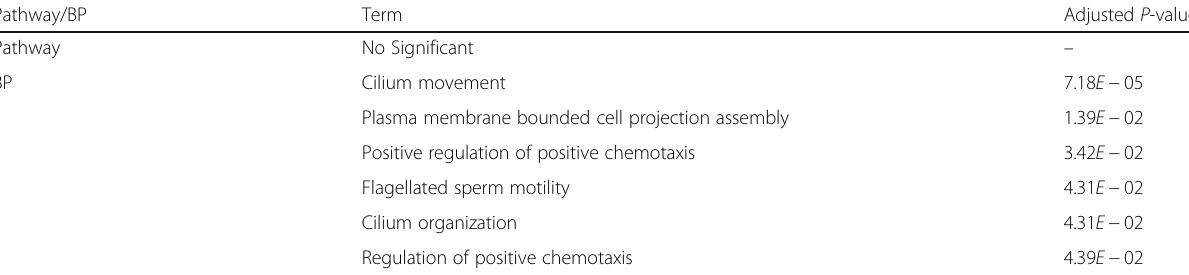
Table 7 Results of the Pathway and GO Biological Process Enrichment Analysis of Overlapping DEGs among Three Diseases Pathway/BP